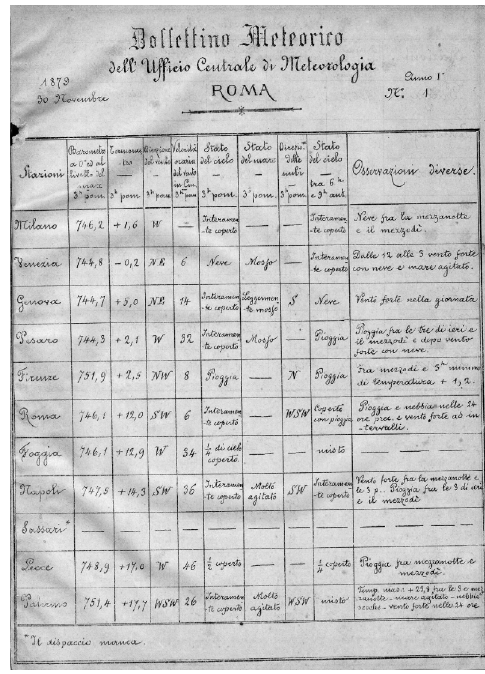
Fig. 1. Pietro Tacchini. Fig. 2. Bollettino Meteorico 30th November 1879 first